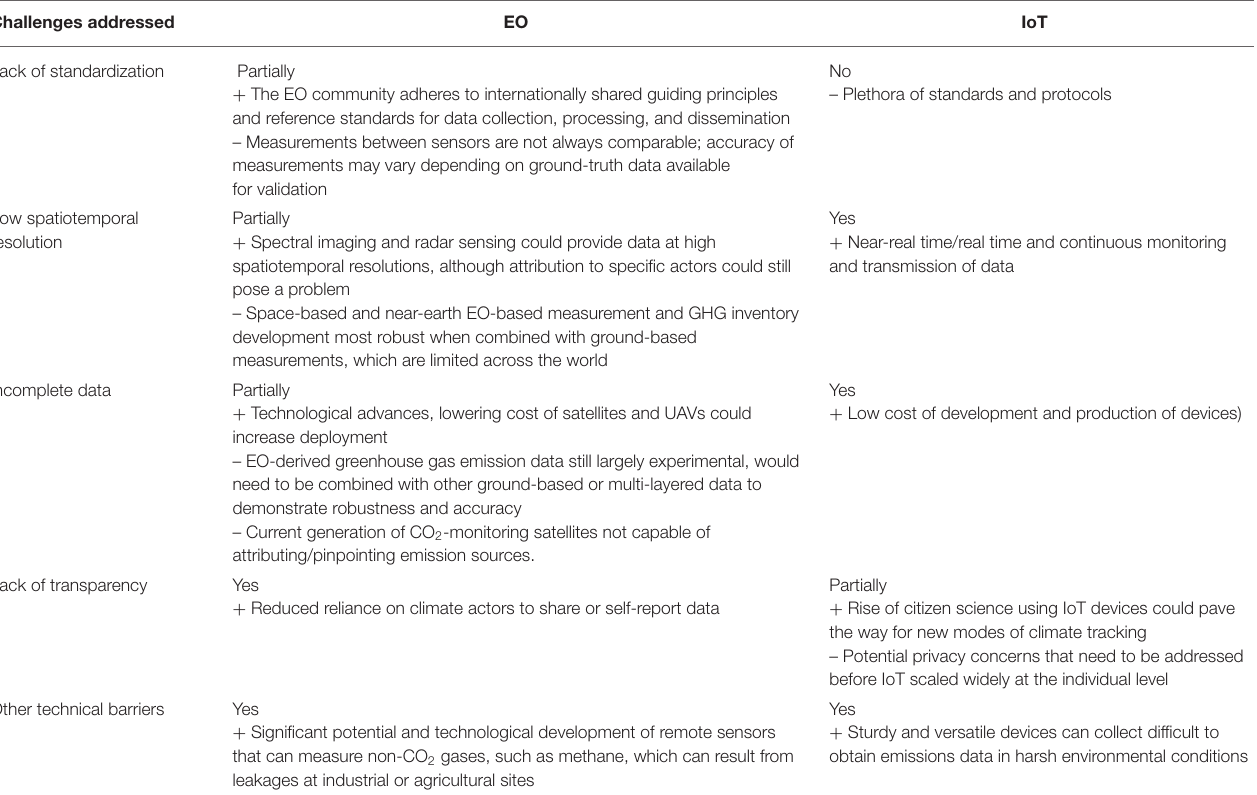
TABLE 1 | Climate mitigation tracking challenges addressed by EO and IoT